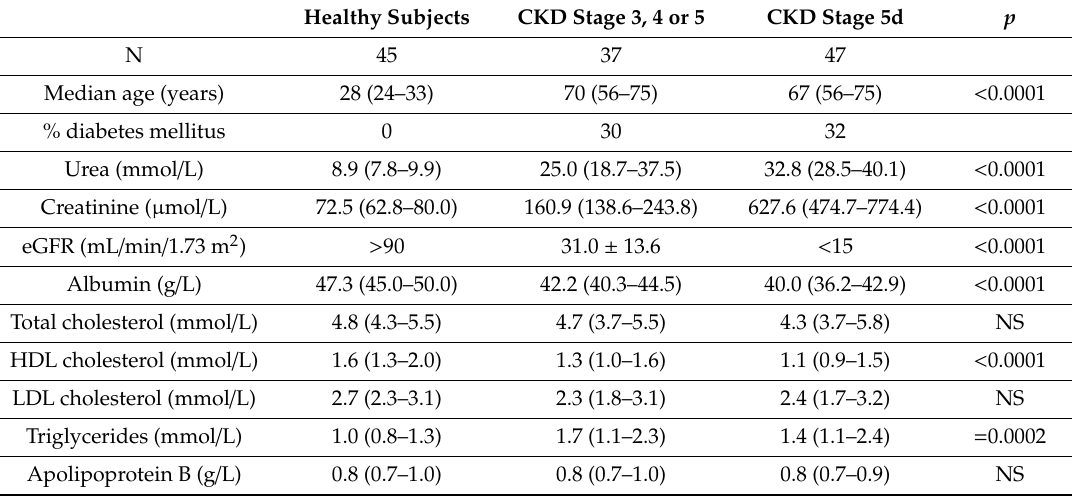
Table 1. General characteristics of the healthy subjects and the chronic kidney disease patients.